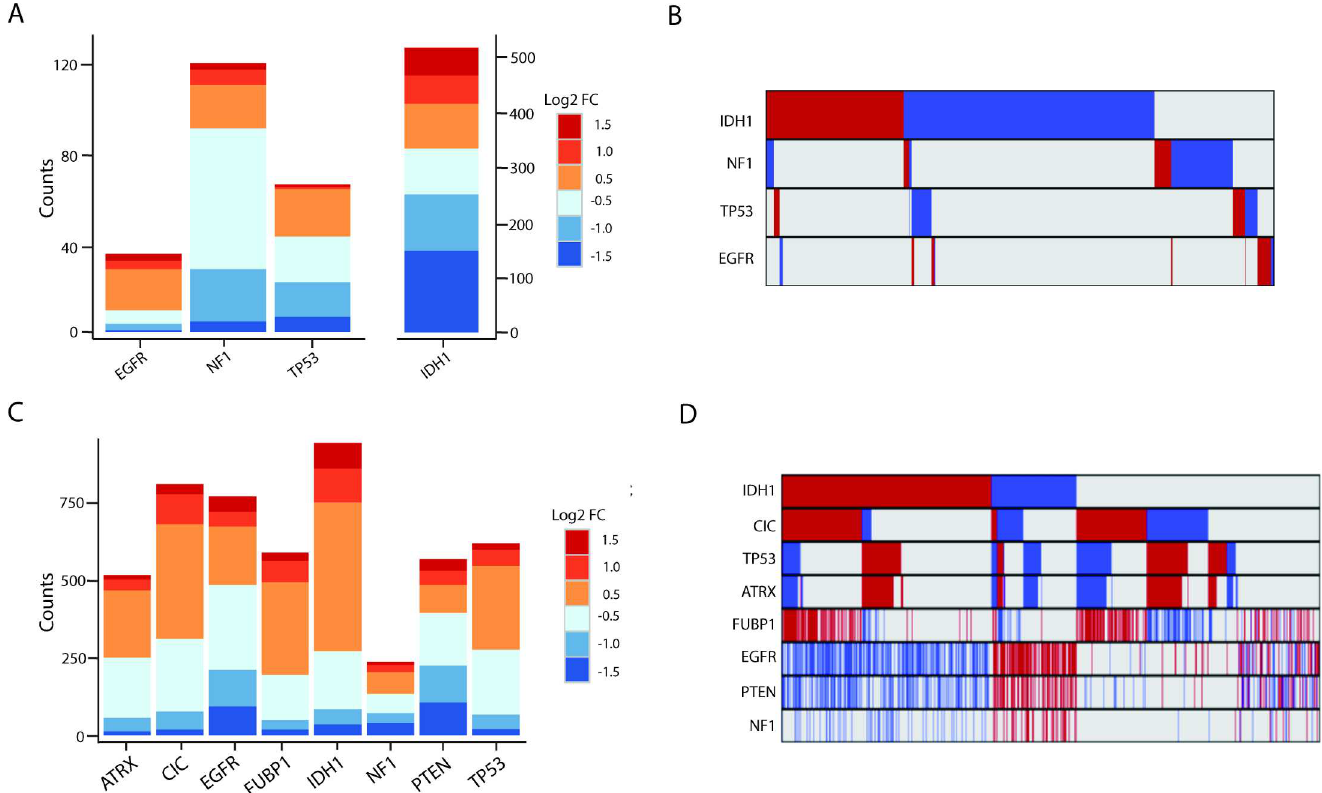
Fig 3. Many lncRNAs are associated with common mutations in GBMs and LGGs. (A) Stacked bar graph of mutation-associatedlncRNAs in GBMs. (B) Minimaloverlap betweenmutation-associatedlncRNAs in GBMs (red = upregulated, blue = downregulated, grey = no change). (C) Stacked bar graph of mutation-associatedlncRNAsin LGGs shows robust deregulation dependingon tumor mutationalbackground. (D) Moderate overlap between mutation-associated lncRNA expressiontrends in GBMs; however, each group of mutation-associatedlncRNAs representsa distinct set of GBMs (red = upregulated, blue = downregulated, grey = no change). GBM, glioblastoma multiforme; LGG, lower grade glioma;lncRNA, long noncoding